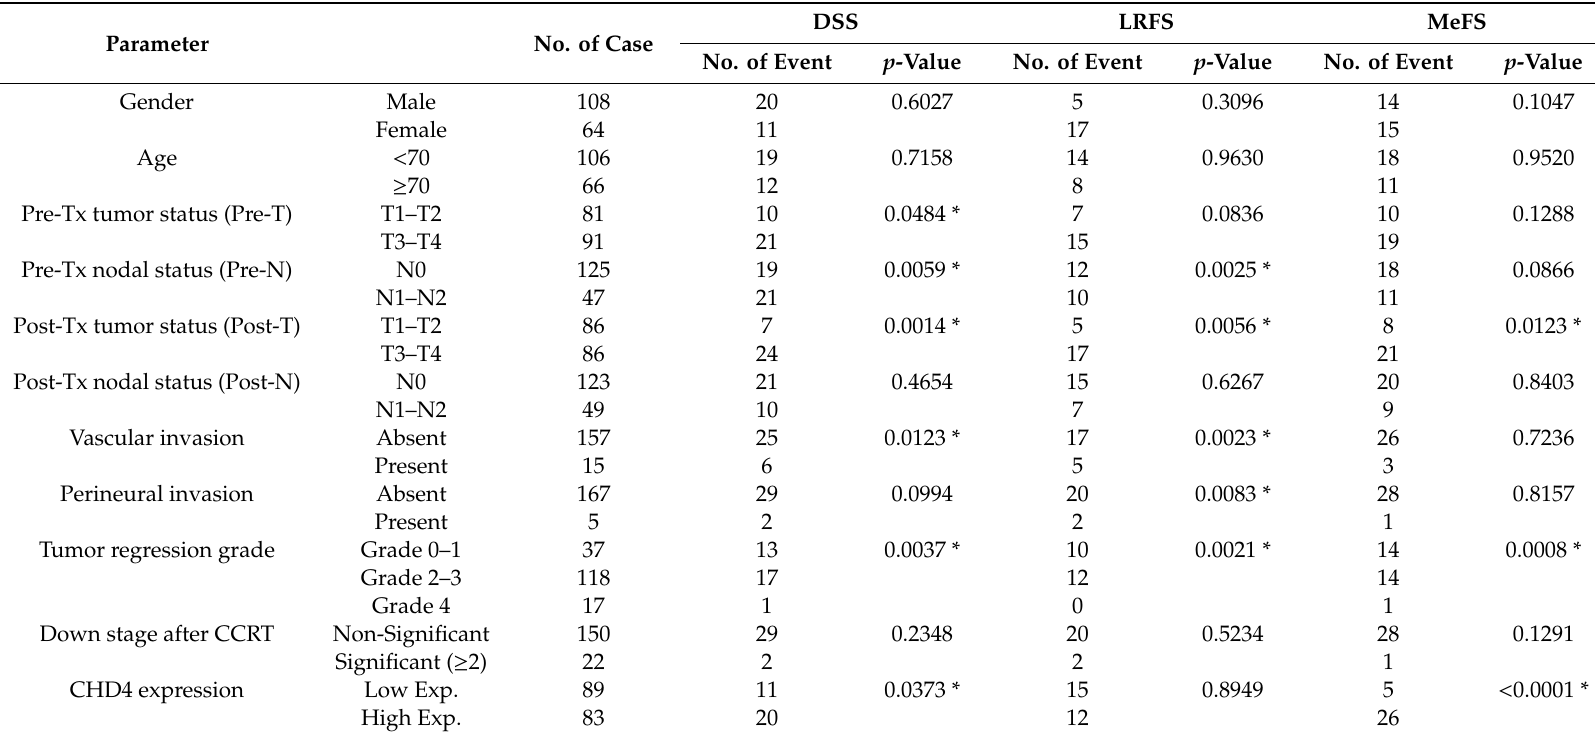
Table 2. Univariate log-rank analysis for important clinicopathological variables and CHD4 expression. In the multivariate regression analysis, CHD4 over-expression was an independent factor of poor prognosis for MeFS ( p = 0.002) after